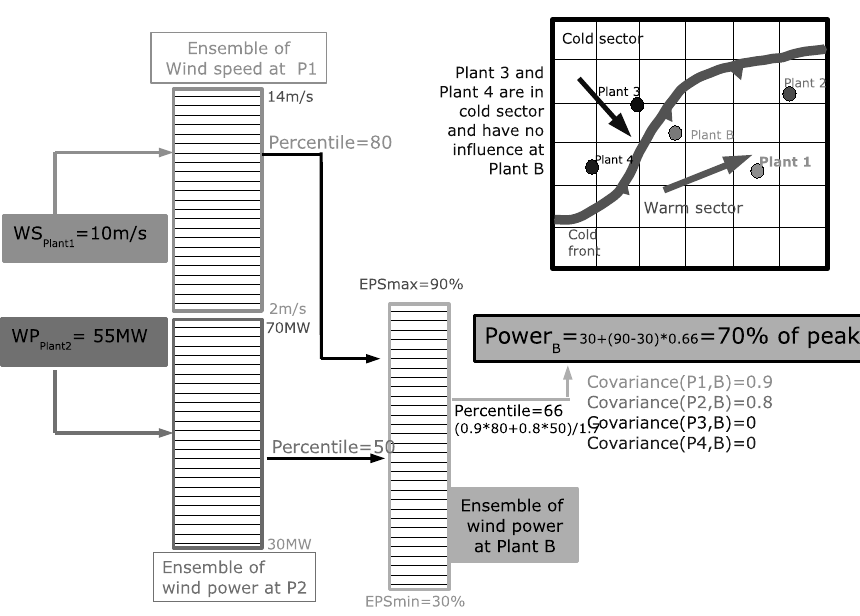
Figure 7. Functionality of the inverted Ensemble Kalman Filter when using different kind of measurements. P stands for